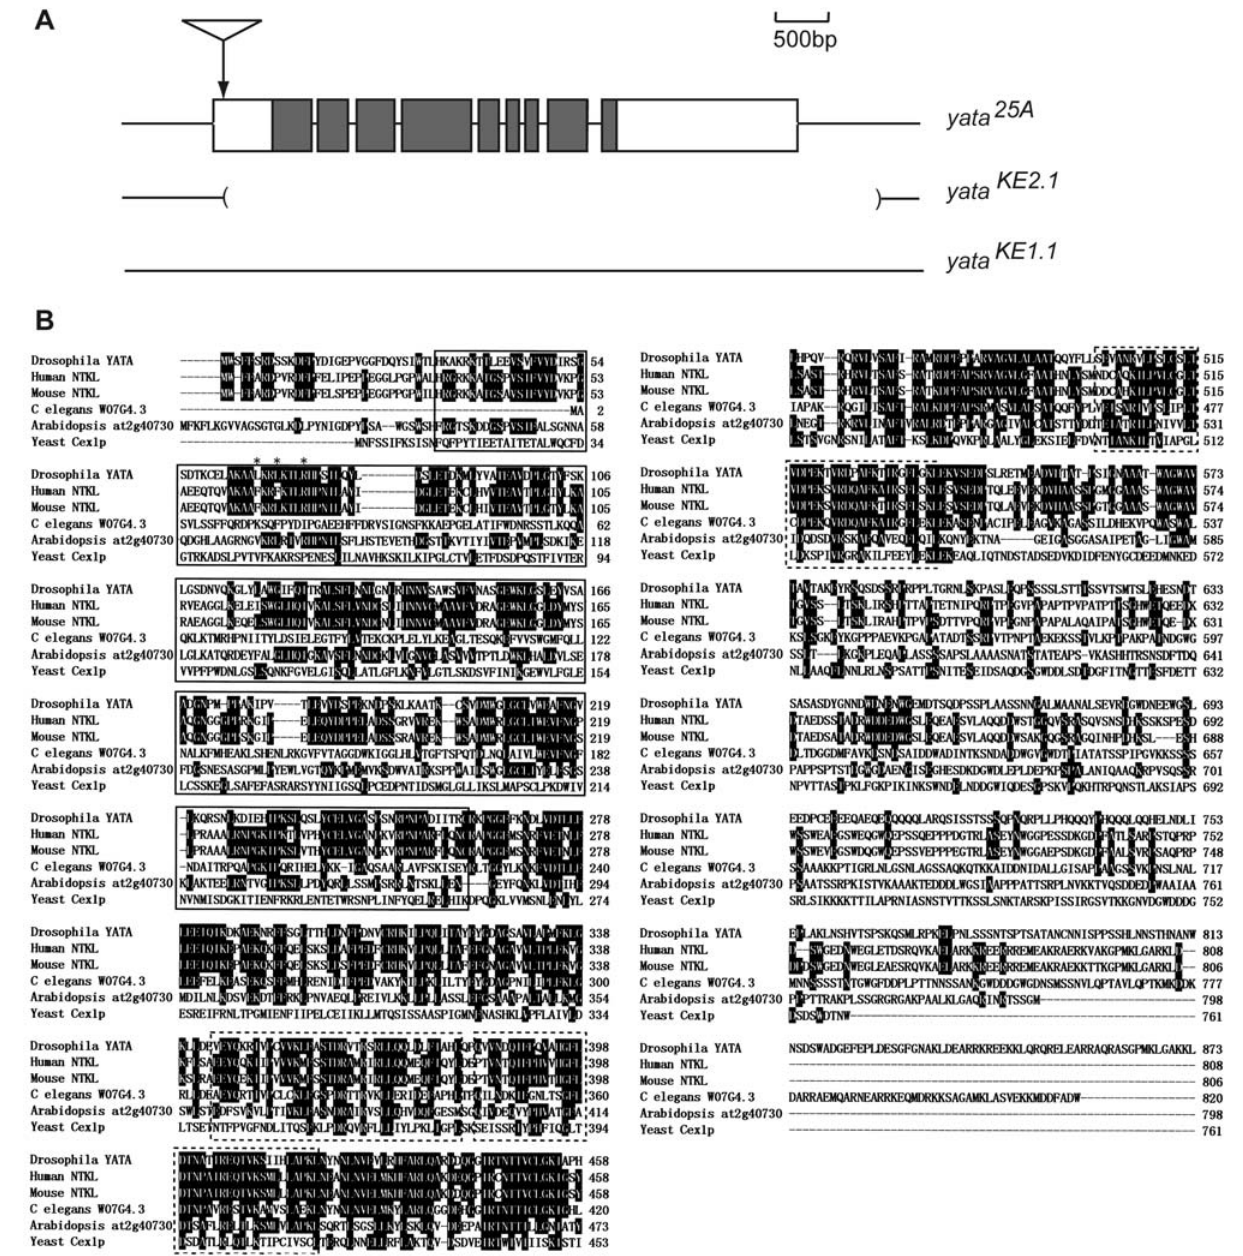
Figure 1. Identification of yata . (A) Schematic structure of the yata gene. Exons are boxed. Shading indicates putative protein coding regions. Molecular lesions of the yata alleles are indicated. The original yata mutant was isolated as an insertional allele of a P-element into the first exon (designated as 25A ). We recovered an allele ( KE2.1 ), in which almost the entire yata gene was deleted along with another allele ( KE1.1 ), in which the P- element had been precisely excised. (B) Amino acid alignment of Drosophila YATA and its related proteins in other species. Identical residues are highlighted. Protein kinase-like domains are indicated by boxes. HEAT repeats are indicated by broken lines. Conserved amino acids of the binding motif with the AP2 b -appendage ([F/I/L]XX[F/L]XXXR) are indicated by ‘*’. Amino acid sequences are shown for YATA/CG1973 ( Drosophila melanogaster , AAF56933), NTKL ( Homo sapiens , AB051427), SCYL1 ( Mus musculus , AF276514), W07G4.3 ( Caenorhabditis elegans , NP_506259), AT2G40730 ( Arabidopsis thaliana , NP_181605) and Cex1p ( Saccharomyces cerevisiae , NP_014755).